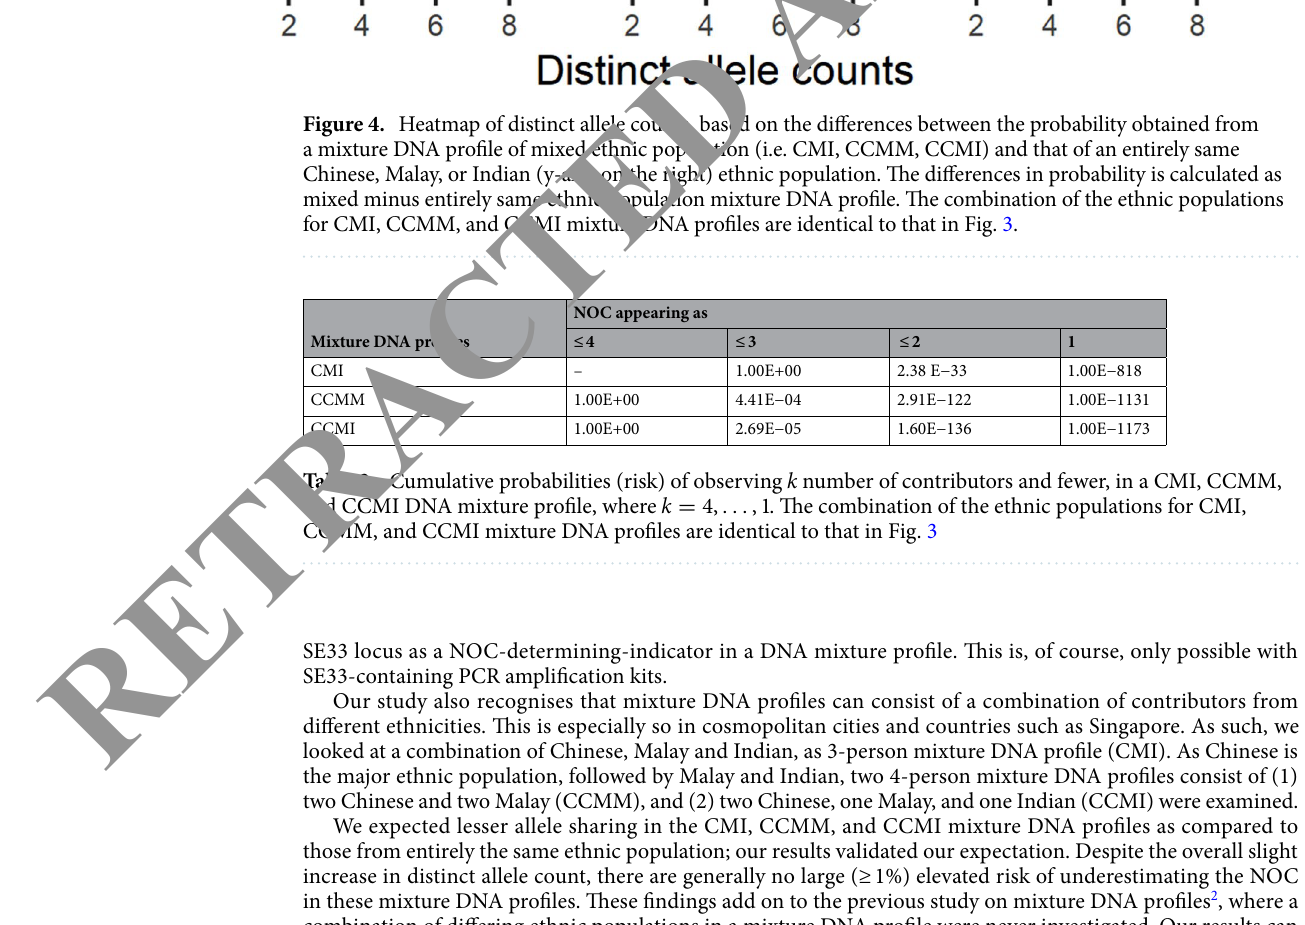
ferent ethnic populations would only deviate slightly from one derived entirely from the same ethnic population.